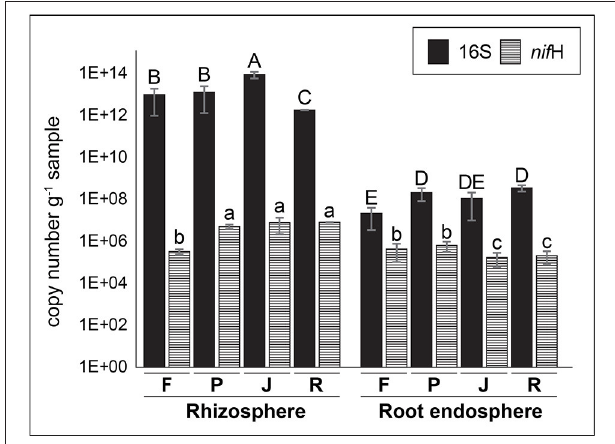
FIGURE 1 | Counts (gene copy number per g of sample) of total and N 2 -fixing bacteria in rhizosphere and root endosphere samples of wheat plants by quantitative PCR (qPCR) using specific primer set for 16S rRNA and nif H genes. Samples labeled as F, P, J, and R correspond to Feña, Patras, Joker, and Rocky wheat cultivars, respectively. Error bars represent standard deviation and different lower letters denote statistical difference ( P ≤ 0.05, Tukey HSD test) ( n = 3).